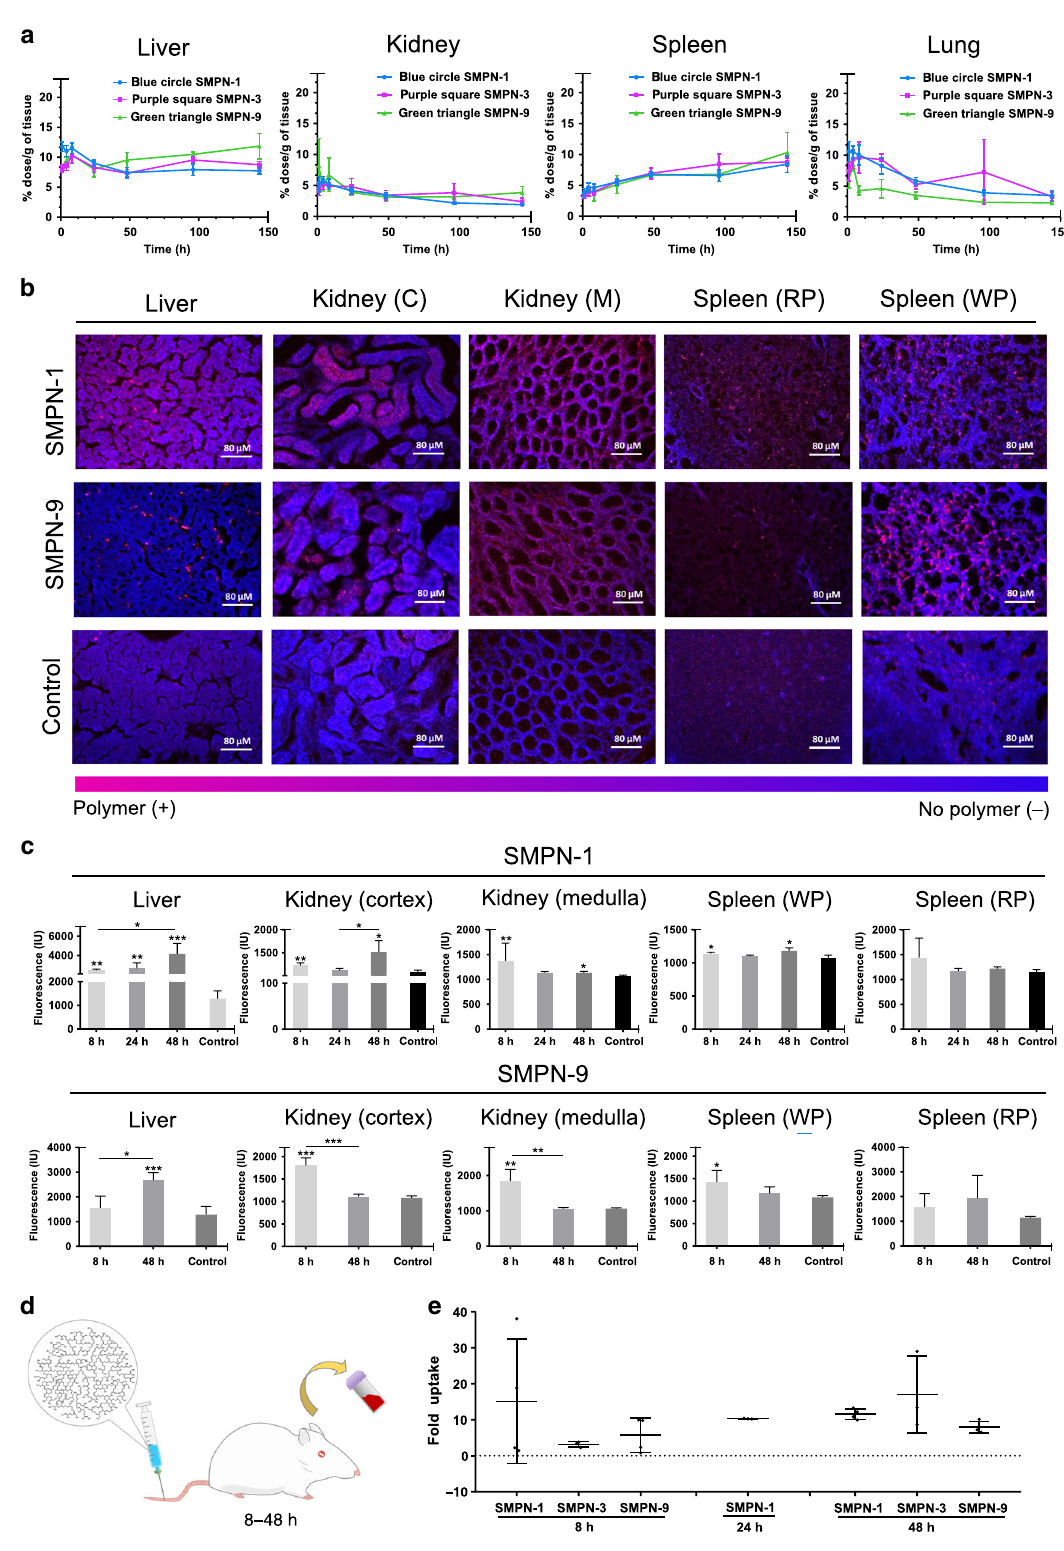
identi fi cation of protein corona on SMPNs were manually assigned through searching the mouse taxon of UnitprotKB database. Percent of abundance for each protein was calculated using label-free quanti fi cation (LFQ) intensities relative to the total sum of protein LFQ intensities for each group. Technical replicate pro fi les from each biological sample were averaged. We